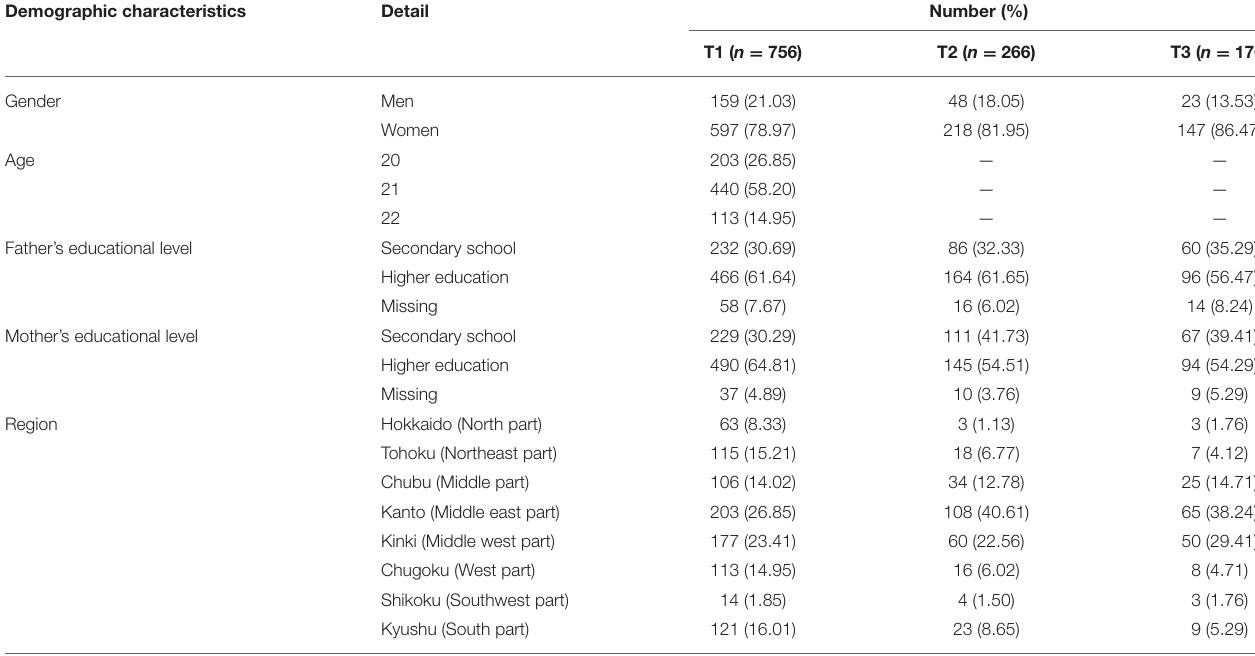
TABLE 1 | Demographic information of the present